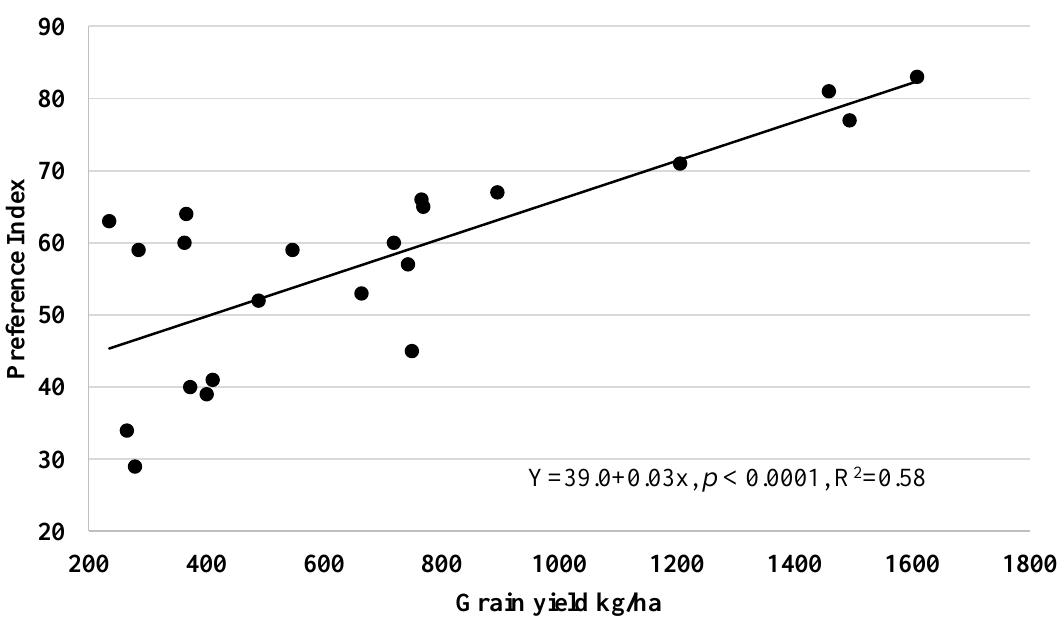
Figure 8. Relationship between preference index and yield in the 2013/2014 season in Yélimané. As in 2013/2014, the varieties with the highest yield in 2014/2015 were among the preferred varieties according to the PI ( R 2 = 0.19) (Figure 9).